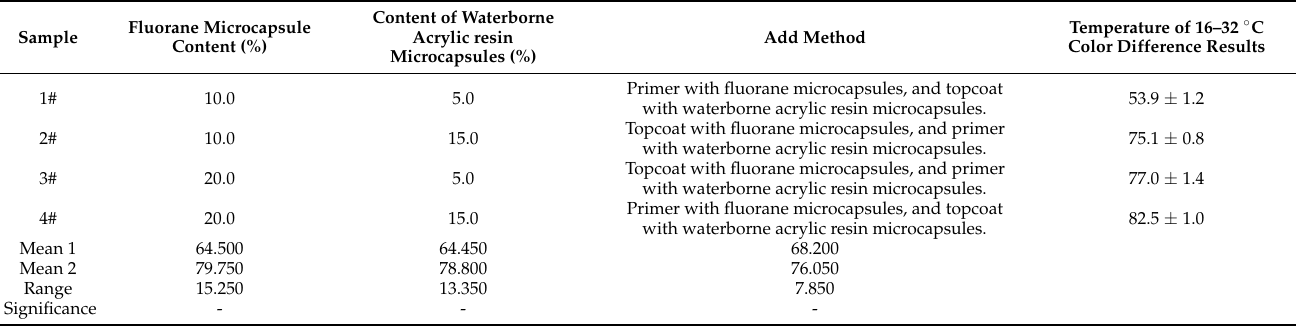
Table 5. Results of orthogonal